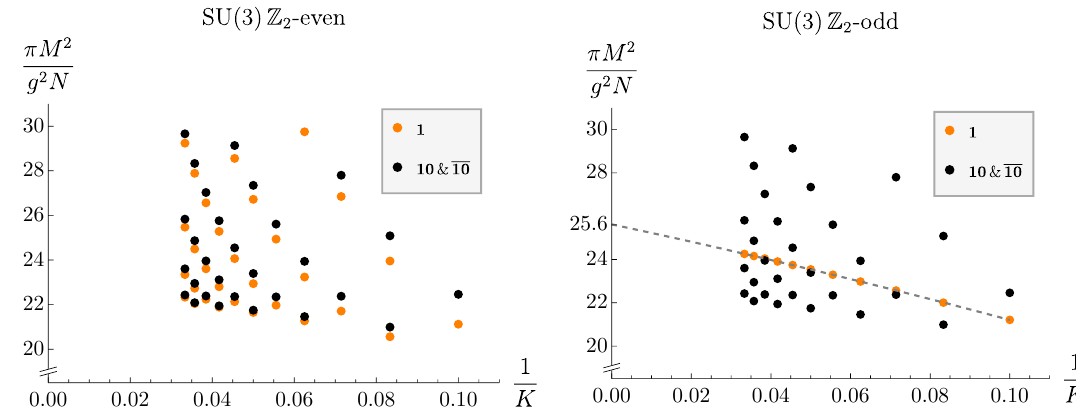
Figure 6 . Part of the bosonic SU(3) spectrum shown in figure 1, here split between Z 2 -even and Z 2 -odd states and with states labeled by the current block they belong